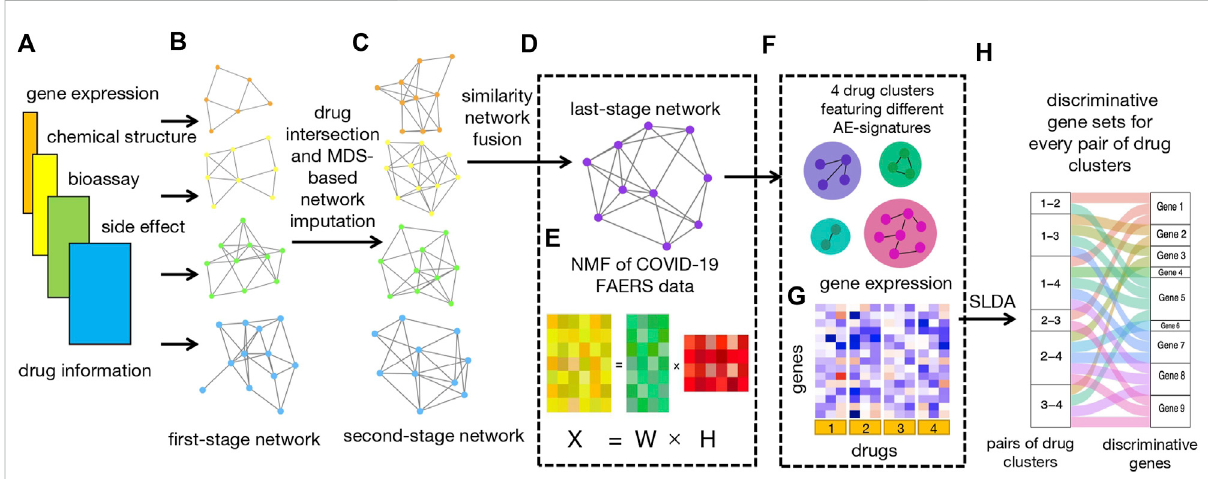
FIGURE 1 Work fl ow. (A) Four types of input data, including bioassay, chemical structure, LINCS, and FAERS data. (B) Construction of four fi rst-stage networks based on four types of drug data. (C) Construction of four second-stage networks based on drug intersection and MDS-based network imputation. (D) Construction of last-stage network from similaritynetworkfusion (SNF). (E) Non-negative matrix factorization (NMF) of count matrix from the CEUAFD; X , drug-AE count matrix; W , AE-signature matrix; and H , drug abundance fraction matrix. (F) Clustering of all COVID-19 drugs by combining results from (D) and (E) , with each cluster featuring one AE signature. (G) Gene expression information extracted from LINCS datawiththeA549celllineforfourclustersofdrugs. (H) Discriminantgenesetsobtainedbysparselineardiscriminantanalysis(SLDA)withrespectto each pair of drug